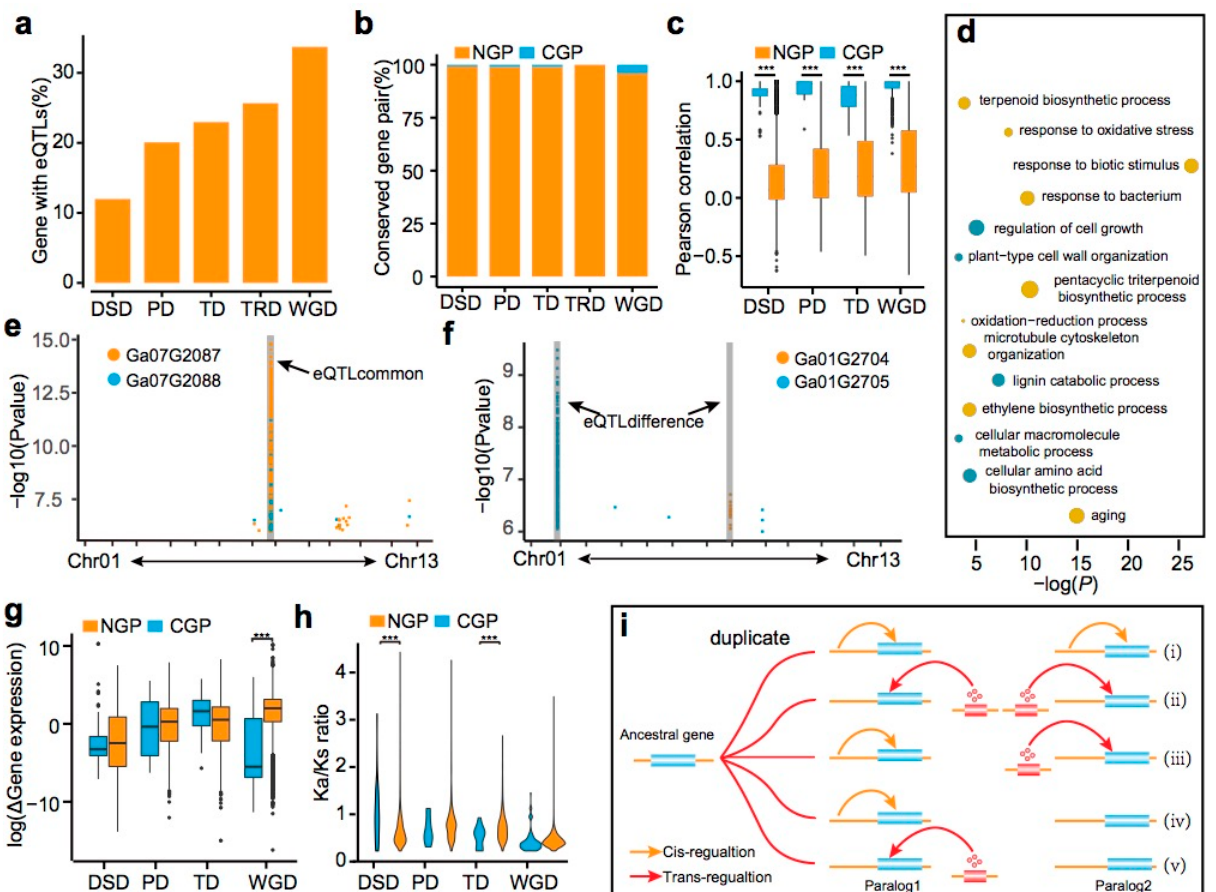
Figure 6. The landscape of eQLTs in five models for gene duplication in G. arboreum . ( a ) Percentage of duplicated genes associated with eQTLs. ( b ) Percentage of conserved gene pair for duplicates among five gene duplication models. ( c ) The divergence of the correlation between conserved gene pairs and non-conserved gene pairs across four gene duplication models of duplicate. ( d ) Gene ontology (GO) enrichment of tandem duplication genes. Student‘s test, *** p < 1 × 10 4 . ( e ) eQTLs on Ga07G2087 and Ga07G2088 expression. ( f ) eQTLs on Ga01G2704 and Ga02G2705 expression. ( g ) The divergence of the gene expression between conserved gene pairs and non-conserved gene pairs across four gene duplication models. Student‘s test, *** p < 1 × 10 4 . ( h ) The divergence of the Ka/Ks between conserved gene pairs and non-conserved gene pairs among four gene duplication models. Student‘s test, *** p < 1 × 10 4 . ( i ) A suggestive model for eQTLs divergence in the duplicated gene pairs.